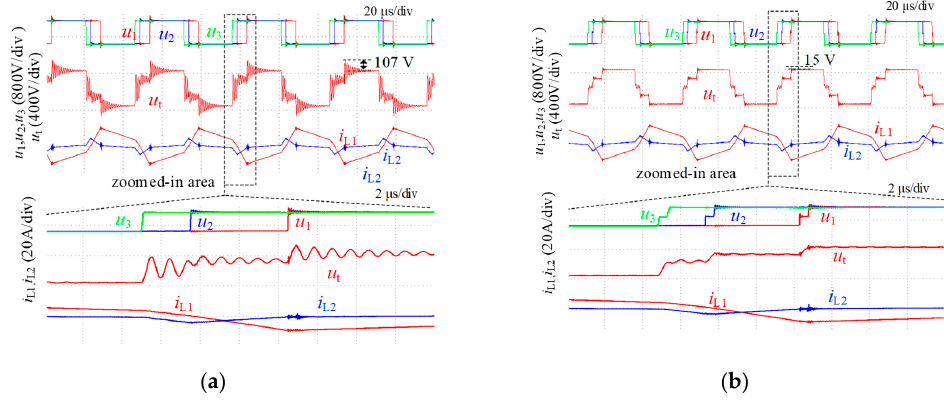
Figure 15. Waveforms of the TAB converter with reverse power flow ( D 1 = 0, D 2 = − 0.2, D 3 = − 0.3): ( a ) no suppression; ( b ) with SHE PS method.